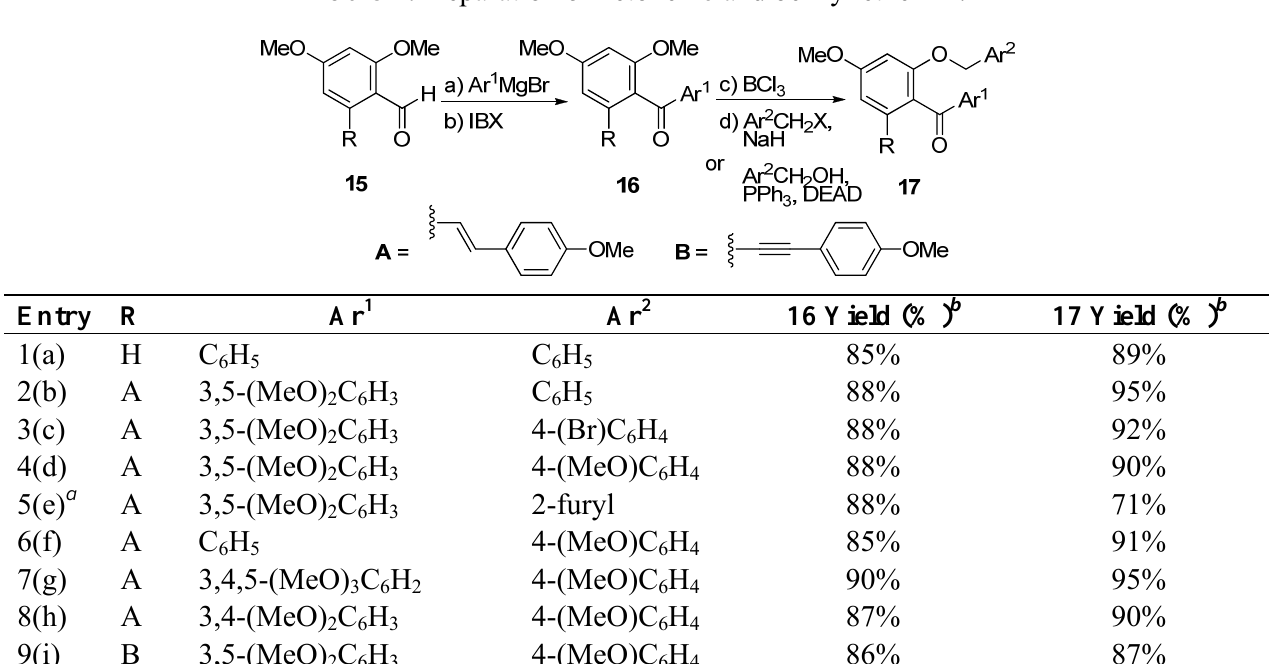
Table 1. Preparation of ketone 16 and benzyl ether 17 .